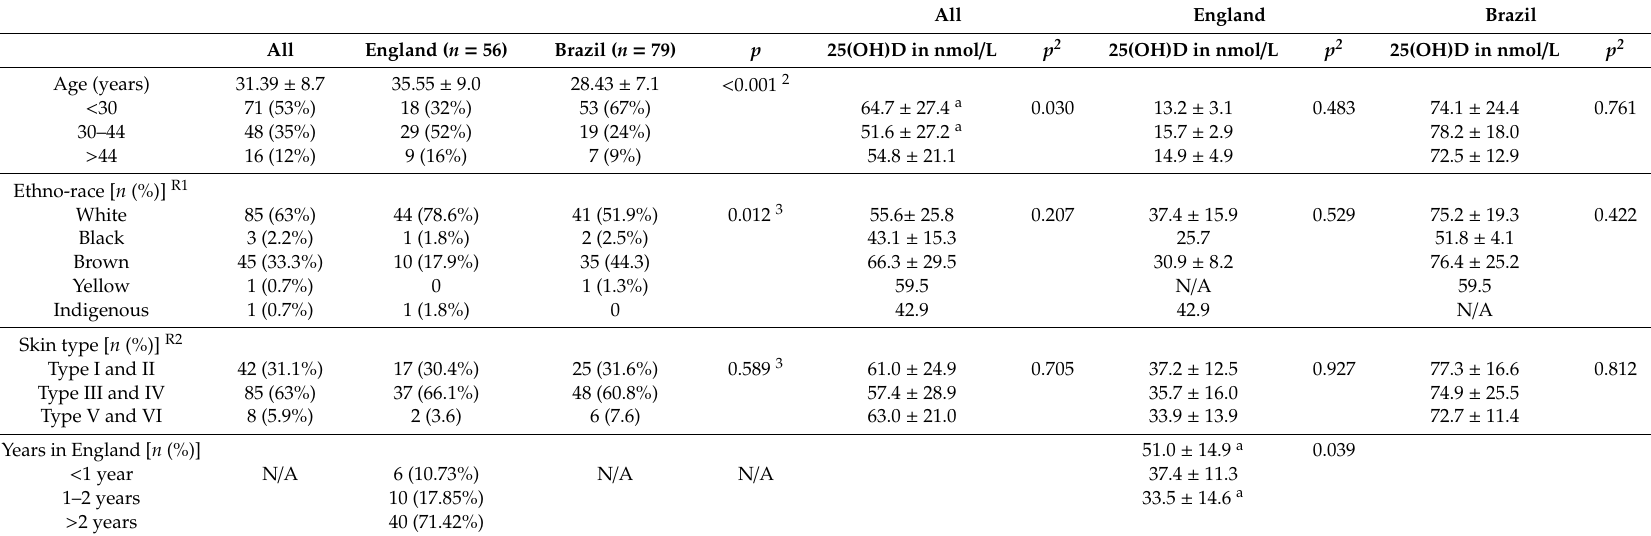
Table 1. Socio-demographic characteristics of adult Brazilian women overall and by country of residence and associations with serum 25(OH)D concentrations ( n = 135) 1